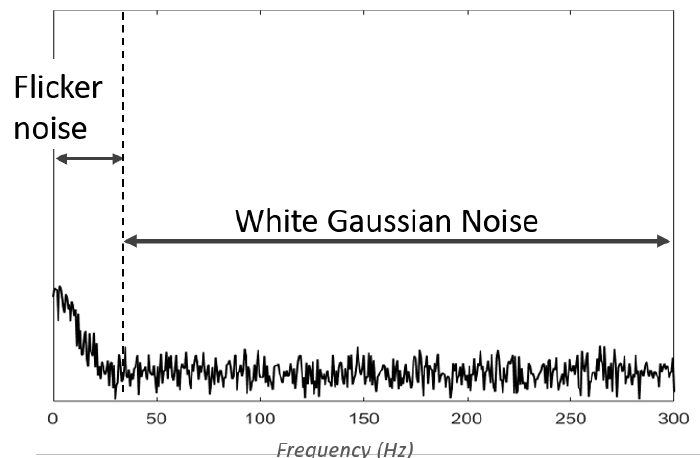
Figure 2. Baseline noise power